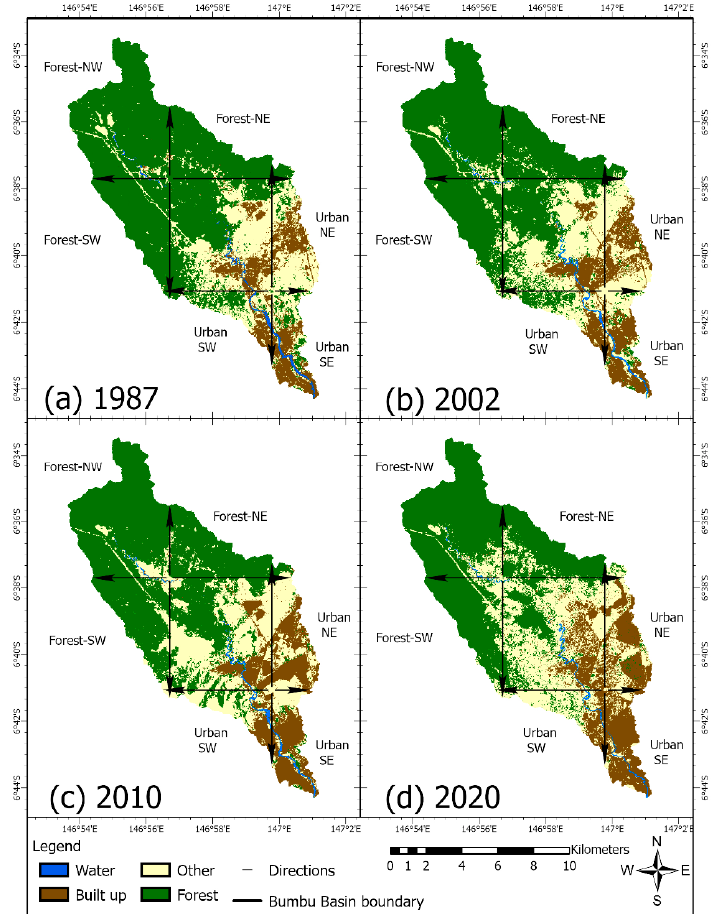
Figure 3. LULC distribution of Bumbu river basin for the years ( a ) 1987, ( b ) 2002, ( c ) 2010, and ( d ) 2020. Table 2. Error matrices of the LULC with commission and omission errors, overall accuracy, producer’s accuracy, user’s accuracy, and kappa coefficient (bold values) for the years 1987, 2002,